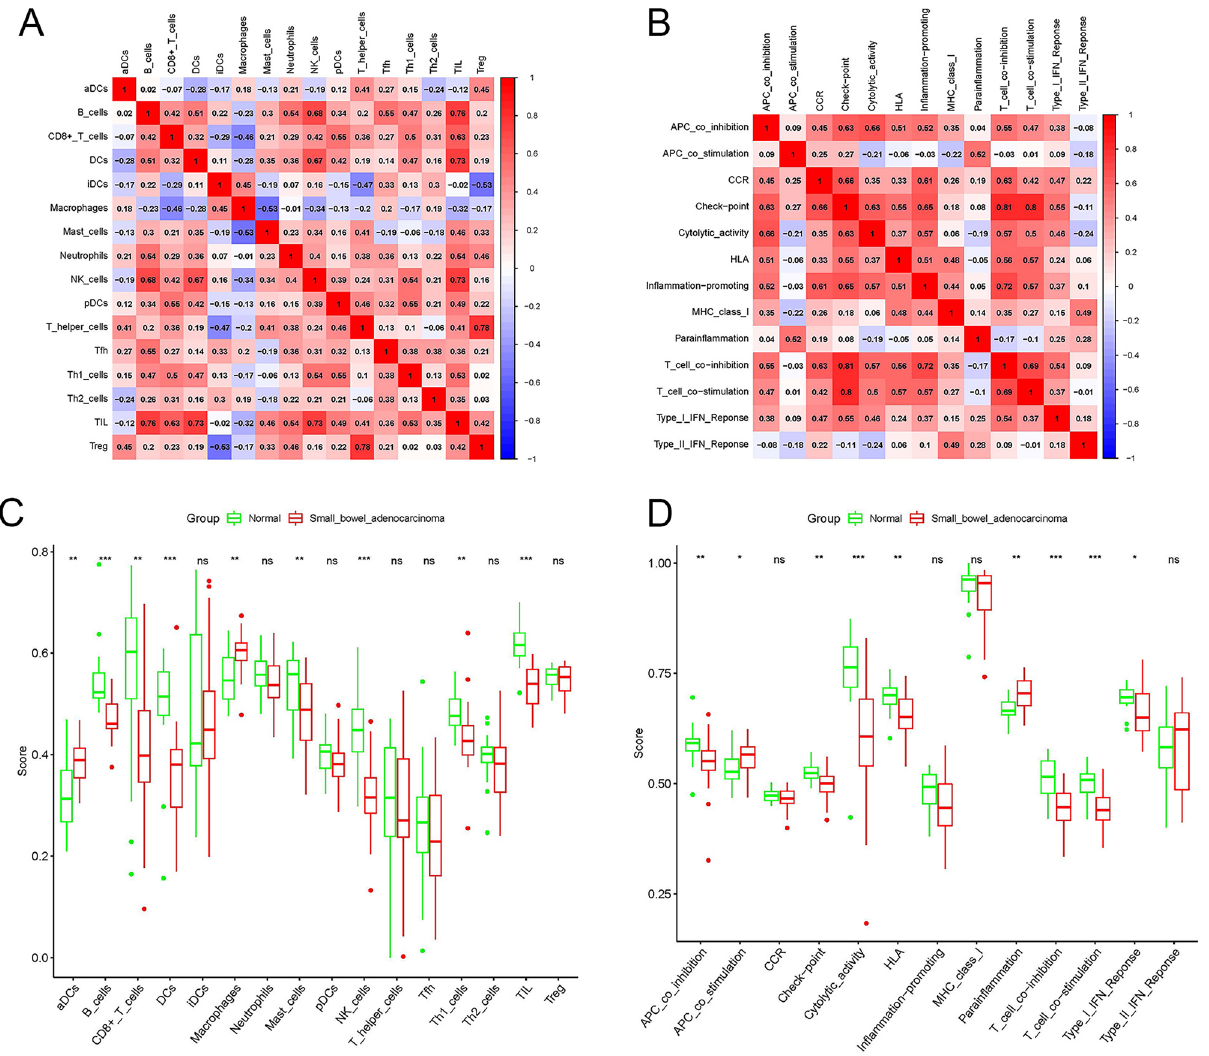
Figure 4. Characteristics of the immune microenvironment in SBA. ( A ) Correlation between immune cells in SBA. Red represents a positive correlation, blue represents a negative correlation. A deeper color indicates a stronger correlation. ( B ) Correlation between immune pathways in SBA. Red represents a positive correlation, blue represents a negative correlation. A deeper color indicates a stronger correlation. ( C ) Comparison of the enrichment scores of 16 types of immune cells between the SBA (red box) and normal group (green box). ( D ) Comparison of the enrichment scores of 13 immune-related pathways between the SBA (red box) and normal group (blue box). SBA small bowel adenocarcinoma, P values: ns not significant; *P < 0.05; **P < 0.01; ***P <